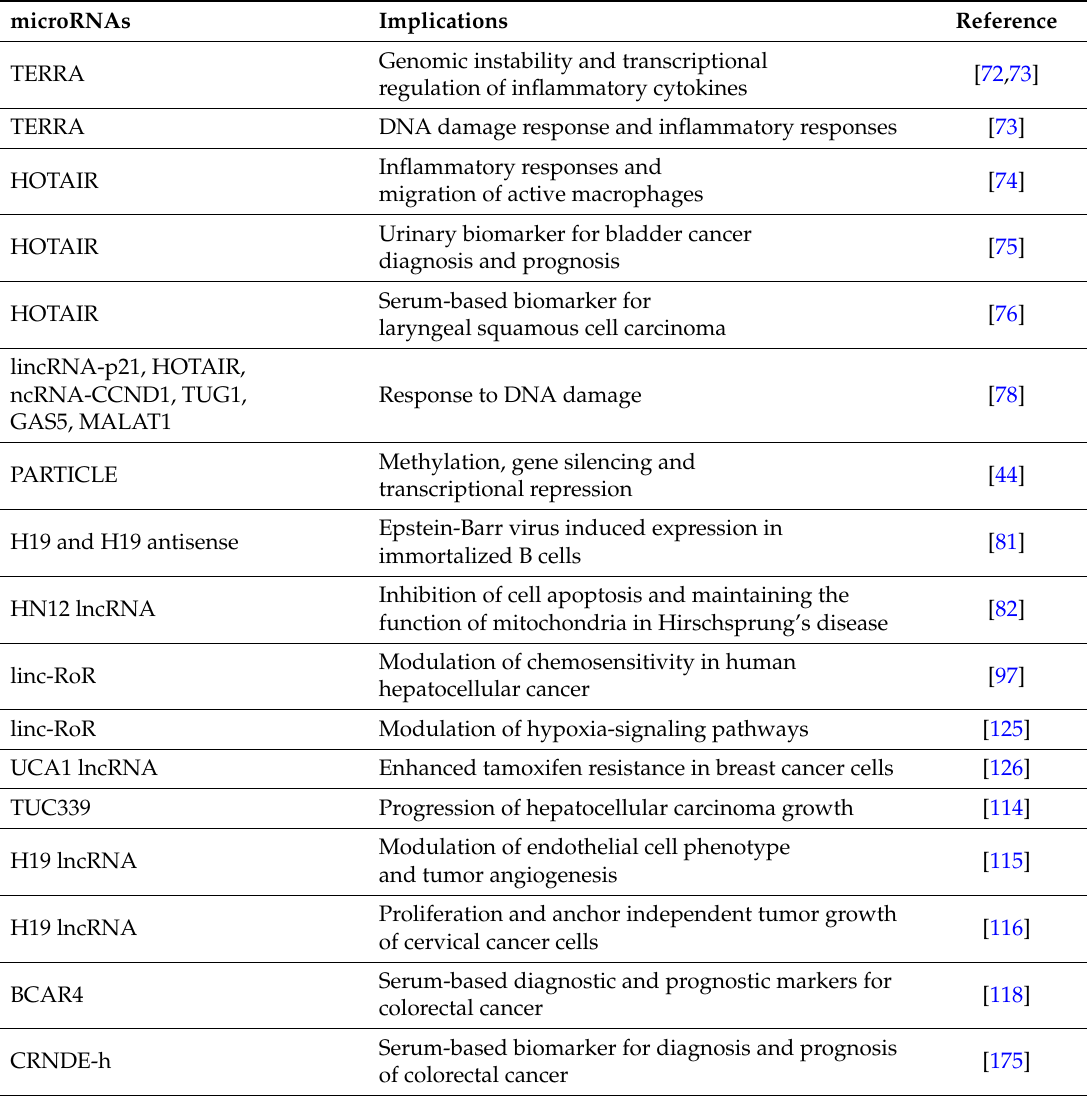
Table 1. Long non-coding RNAs in extracellular vesicles implicated in epigenetic regulation, tumor progression and drug